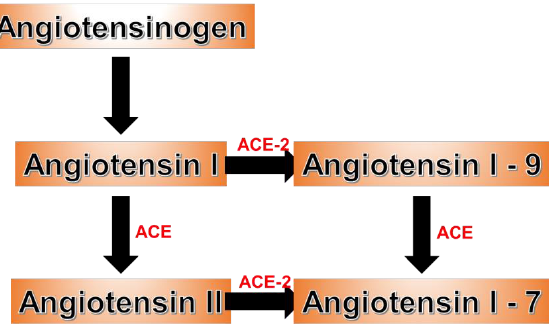
Figure 8. ACE-2 is needed to convert pro-inflammatory angiotensin II (ANG-II) to anti-inflammatory ANG (1-7) in the renin-angiotensin system (RAS). As COVID-19 competes for ACE-2, less ANG-II is